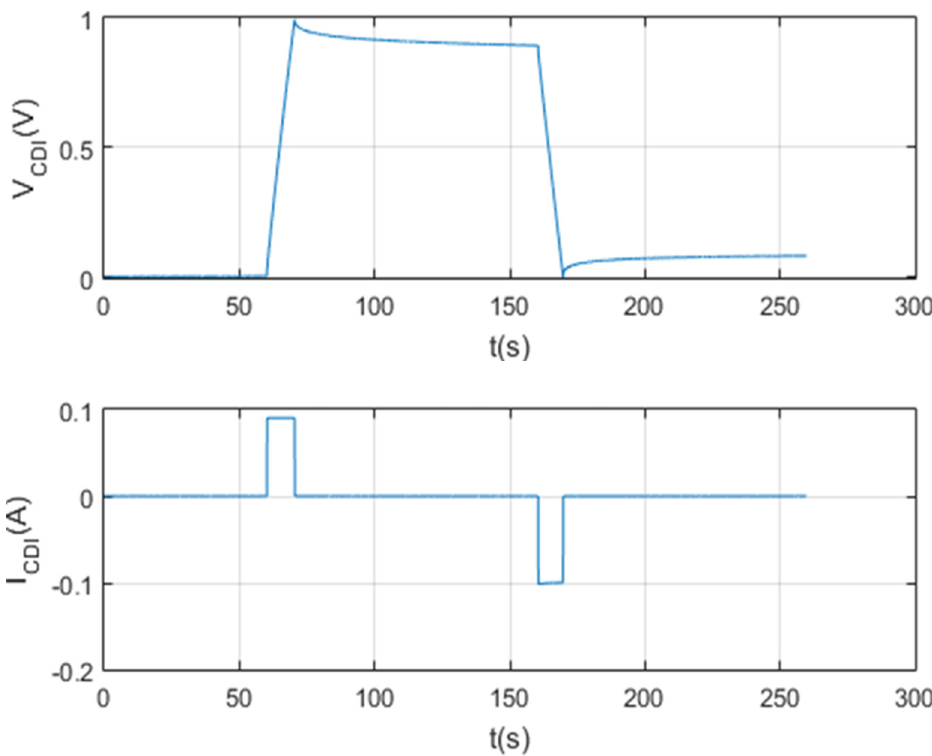
Figure 22. Charge and discharge test at Vcmax = 1 V and Icon = 0.1 A.